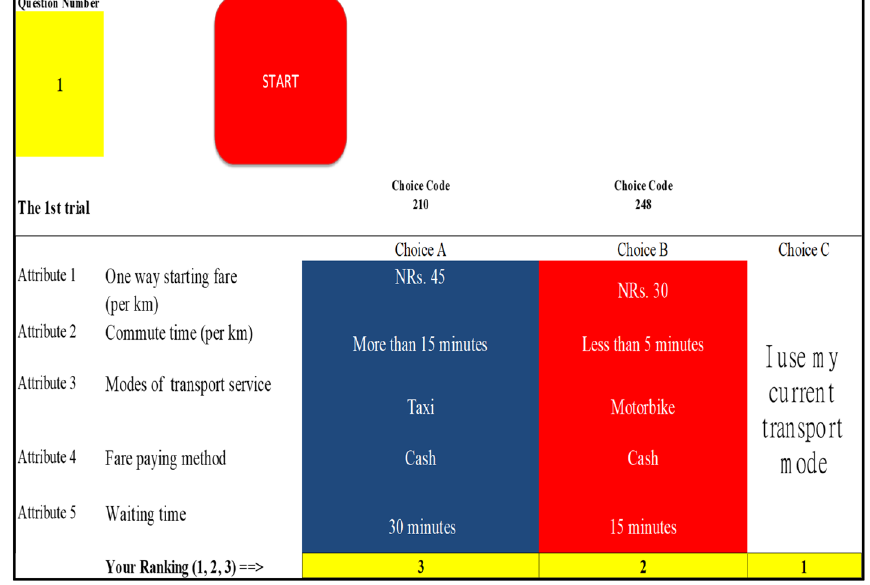
Fig. 2 An example of the choice